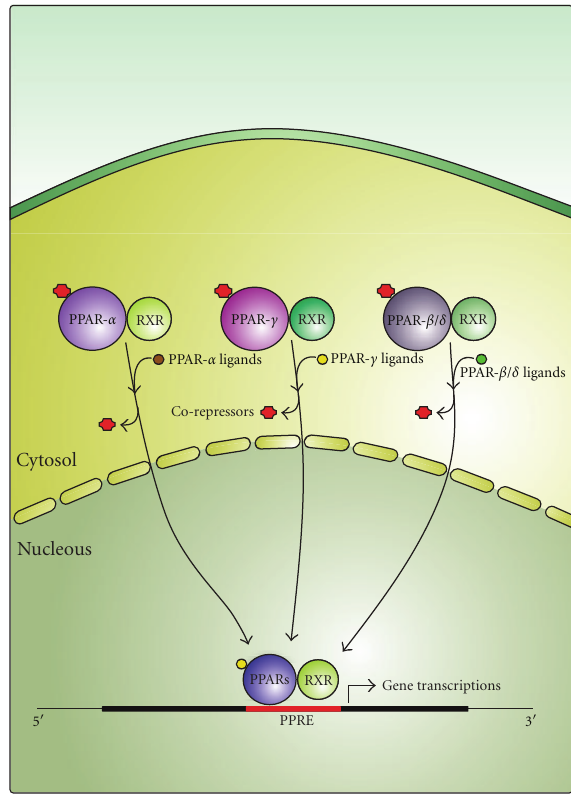
Figure 1: A proposed mechanism of ligand-mediated activation of PPARs. In response to ligand binding, PPARs undergo confor- mational changes in protein structure. This allows dissociation of corepressor proteins which inhibit transcription and the recruit- ment of co-ac-tivators. PPAR-RXR heterodimers bind to specific recognition sites of DNA, termed peroxisome proliferator activated receptor response elements (PPREs) located in the regulatory region of target